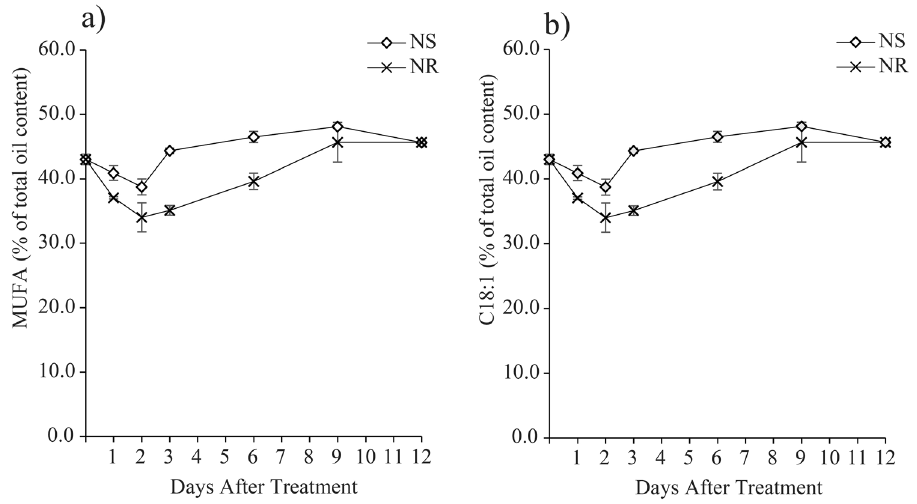
Figure 4. Effects of nitrate availability on monounsaturated (MUFA) composition of M. gracile SE-MC4 cultivation during early (day 1, 2 and 3), mid (day 6 and 9) and late (day 12) treatment periods. ( a ) Overall MUFA production, ( b ) percentage of C18:1 of M. gracile under NS and NR conditions. The values are presented as means ± standard deviation (SD) (n =